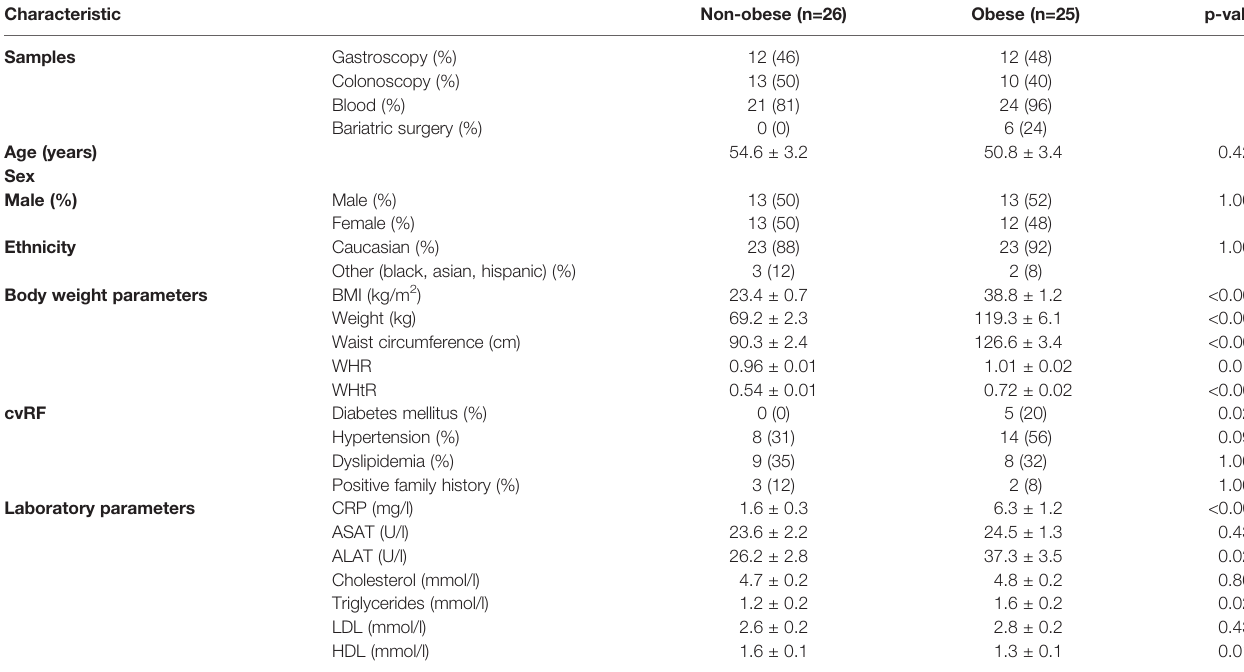
TABLE 1 | Baseline characteristics of study